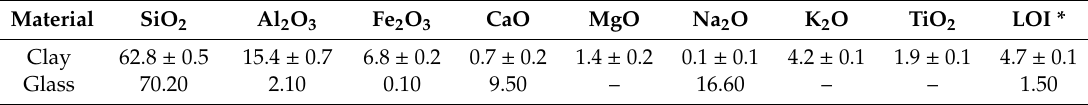
Table 1. The chemical composition and LOI in wt% of the Liepa clay and bottle